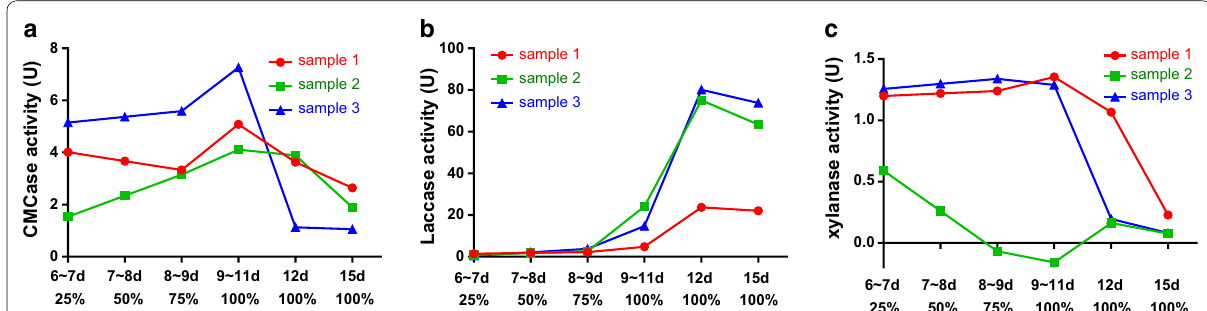
Fig. 6 a CMCase activity of P. ostreatus during solid-state fermentation. b Laccase activity of P. ostreatus during solid-state fermentation. c Xylanase activity of P. ostreatus during solid-state fermentation